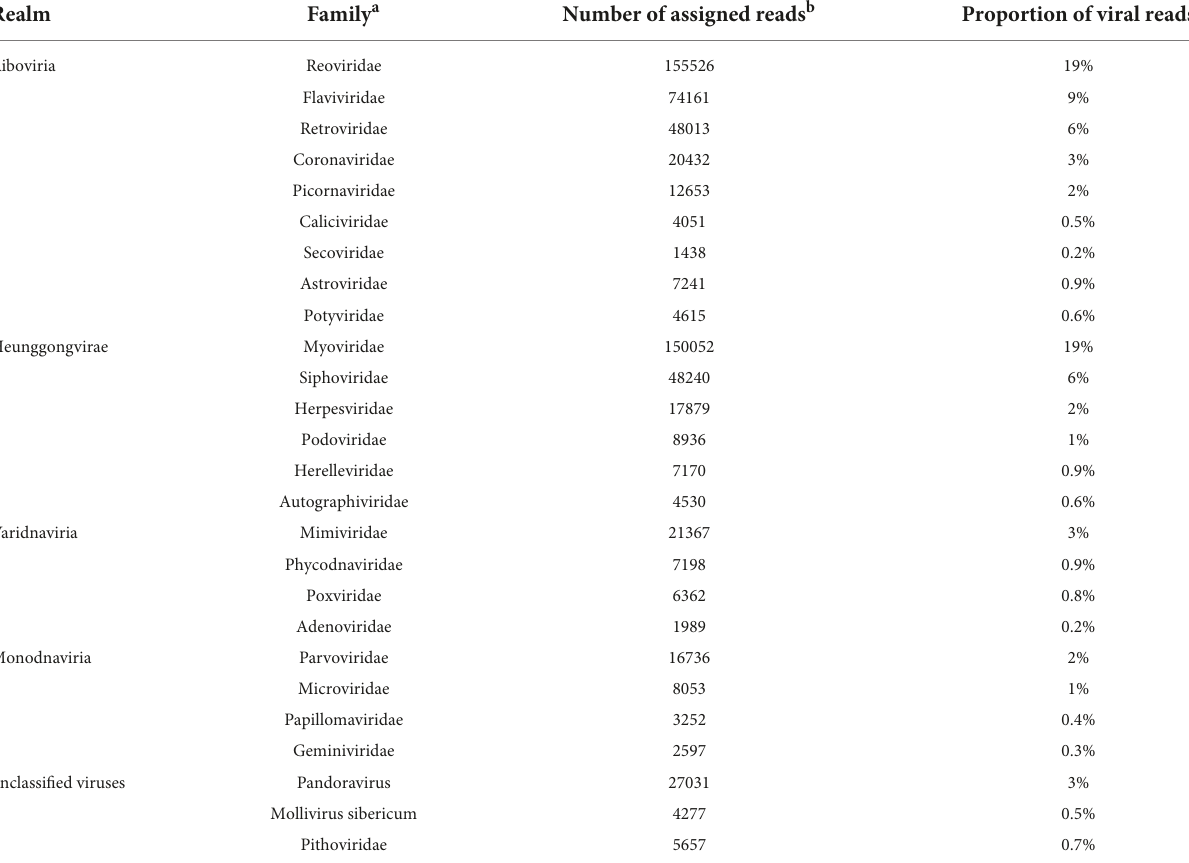
TABLE 1 The statistics of viral reads assigned to different families. Realm Family a Number of assigned reads b